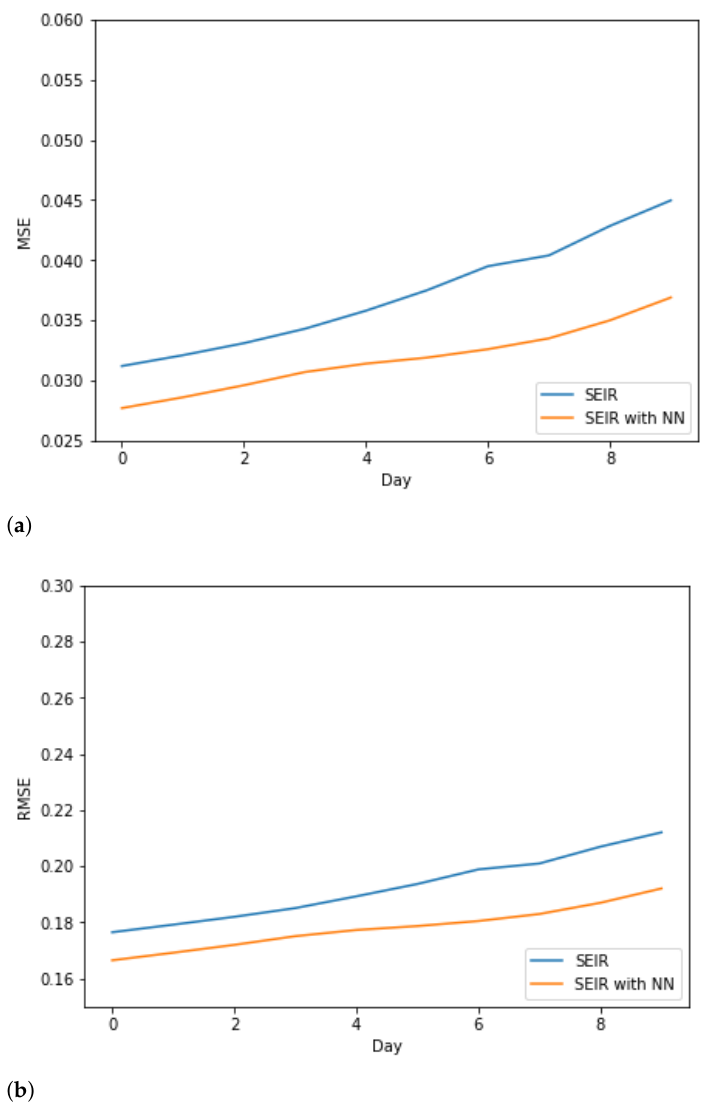
Figure 6. ( a ) Mean Squear Error (MSE) and ( b ) Root Mean Squeare Error (RMSE). The cross-validation result (mean accuracy) for the model combining SEIR with a neural network is shown in Table 3. Table 3. Cross validation result (mean) of the SEIR model with a neural network.